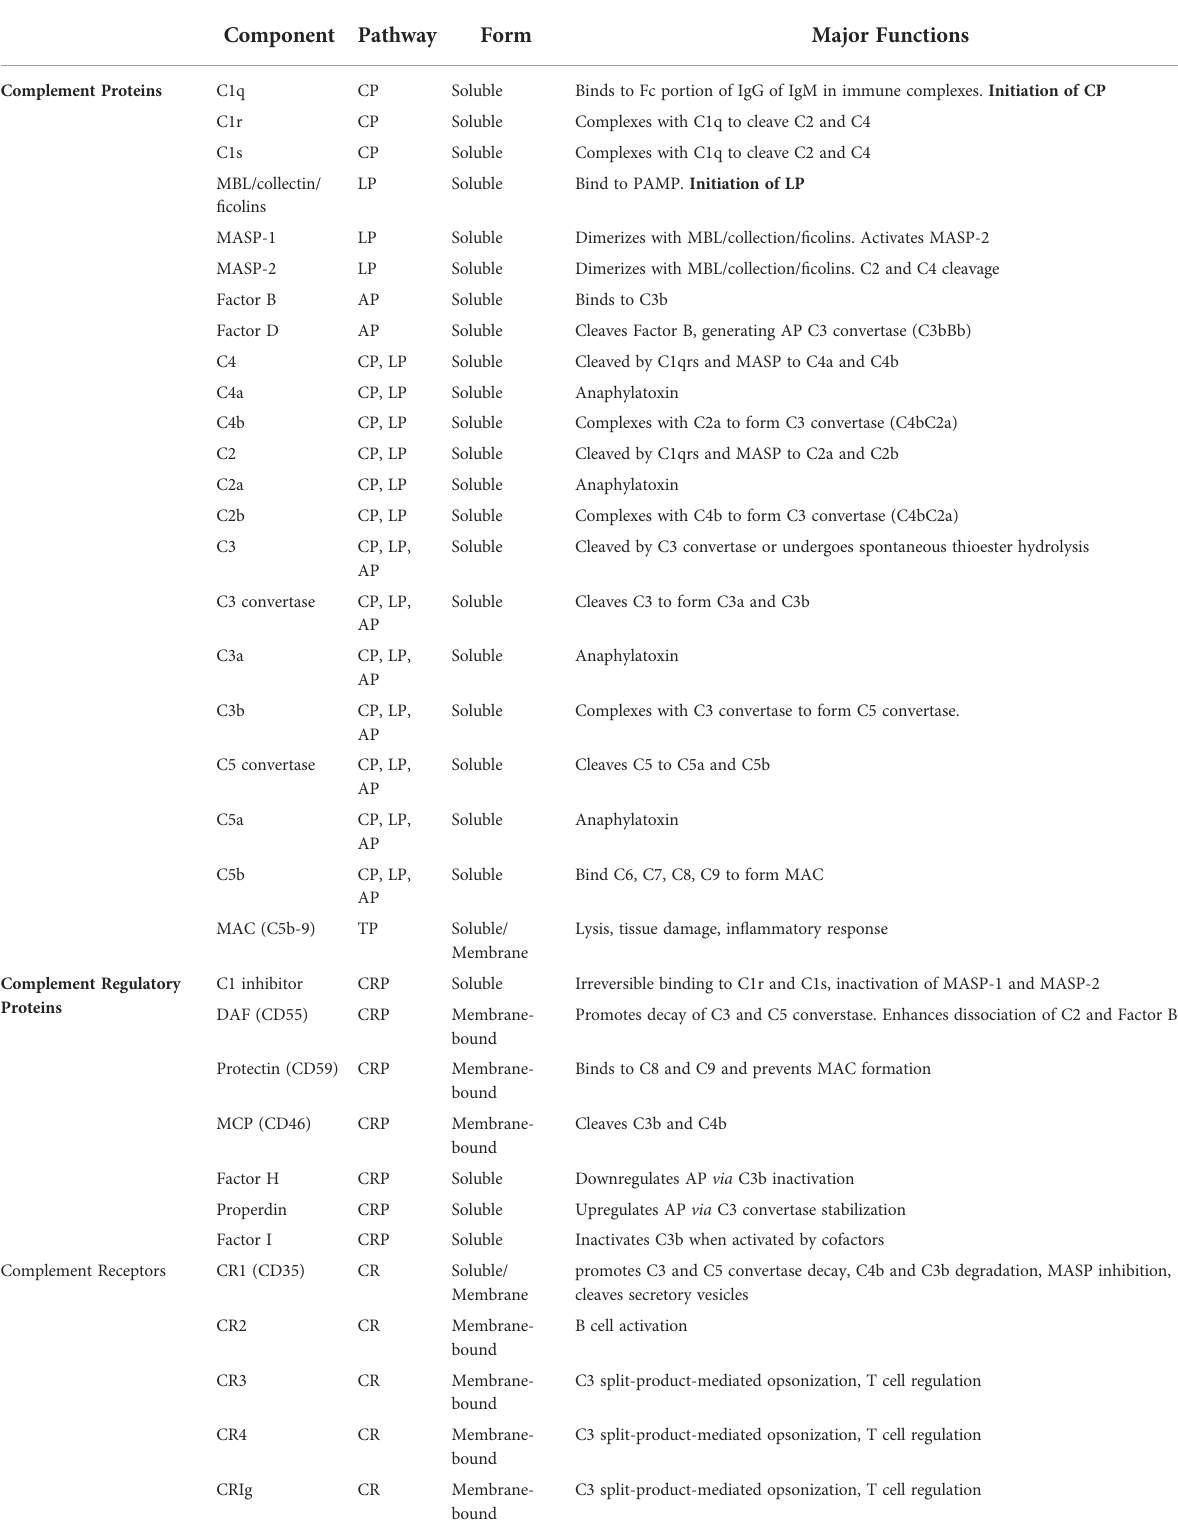
TABLE 1 Major components of the complement system and their